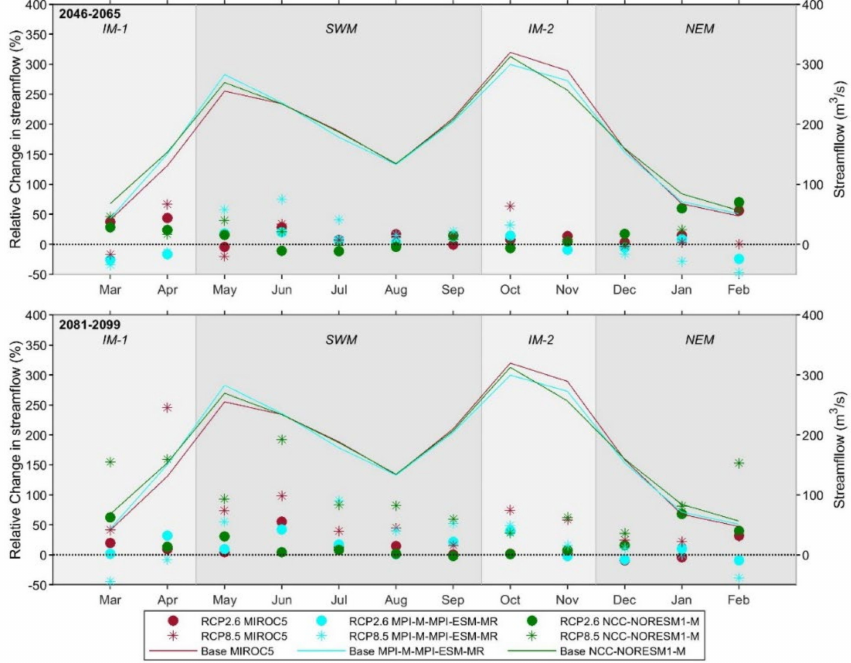
Figure 6. Percentage change in projected mean monthly streamflow at the basin outlet relative to the baseline period (1991–2005) and absolute values for baseline period for simulations forced with the three RegCM4 RCM data. In each panel, relative changes for future periods are in the primary (left Y-axis) and streamflow for baseline periods are in the secondary axis (right Y-axis). The top panel shows the mid-century period (2046–2065) and the bottom panel shows the end-century period (2081–2099). Each panel shows the results of simulations forced with three RegCM4 RCMs (MIROC5, MPI-M-MPI-ESM-MR, and NCC-NORESM1-M) under both RCP 2.6 (filled circles) and RCP 8.5 (asterisks). Shaded areas represent the four monsoon